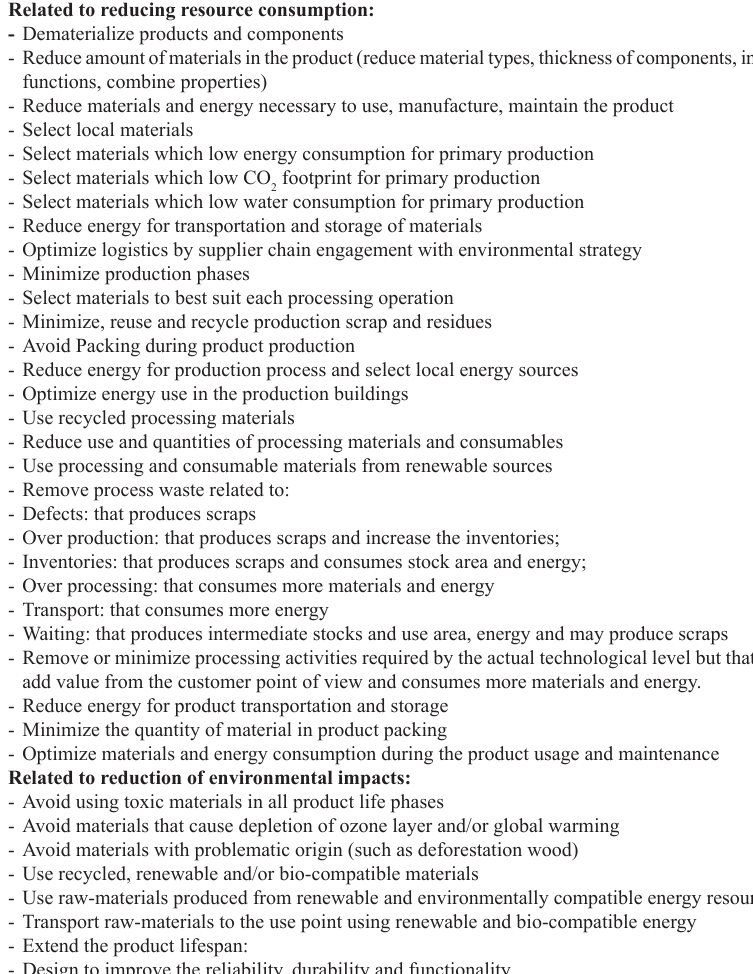
Table 1: Product sustainability strategies that affect materials selection in product design. Design strategies for product sustainability improvement that influence material